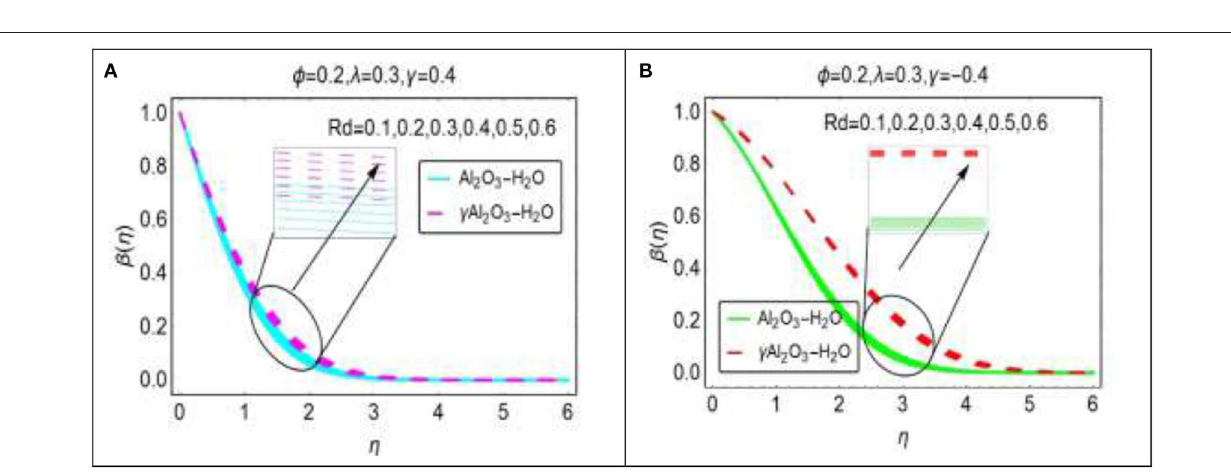
Frontiers in Physics |